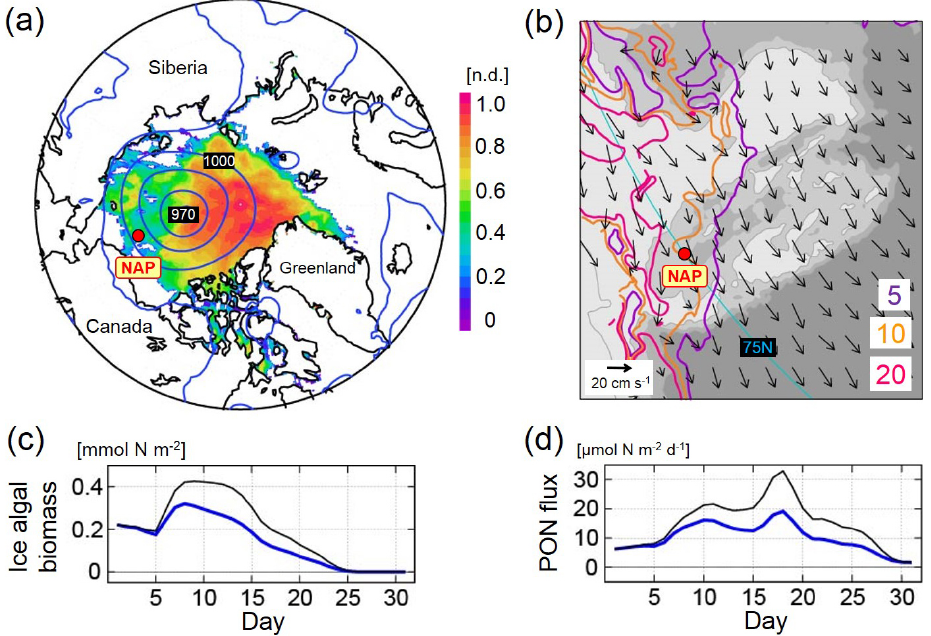
Figure 12. (a) NCEP/CFSR (contours) sea level pressure (hPa) and (shade) sea ice concentration (n.d.) on 6 August 2012. (b) Modeled (contours) PON flux at the depth of 180m and (vectors) sea ice motion averaged for 3–10 August in the 2012 case. The flux contours of 5, 10, and 20µmolNm 2 d − 1 are shown around the Chukchi Borderland. The sea ice motion is overlaid every 10 grid (i.e., approximately 50km), and its unit vector is 20cms − 1 . Red dots denote the location of Station NAP. August time series of the modeled (c) ice algal biomass (mmolNm − 2 ) and (d) PON flux (µmolNm − 2 d − 1 ) in the 2012 case (black lines) and the no ice algal activity case (blue